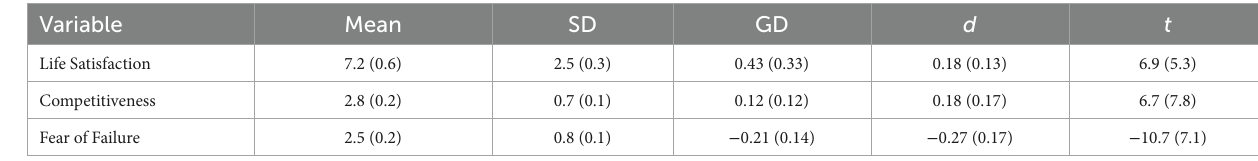
TABLE 1 Descriptive statistics of country-level